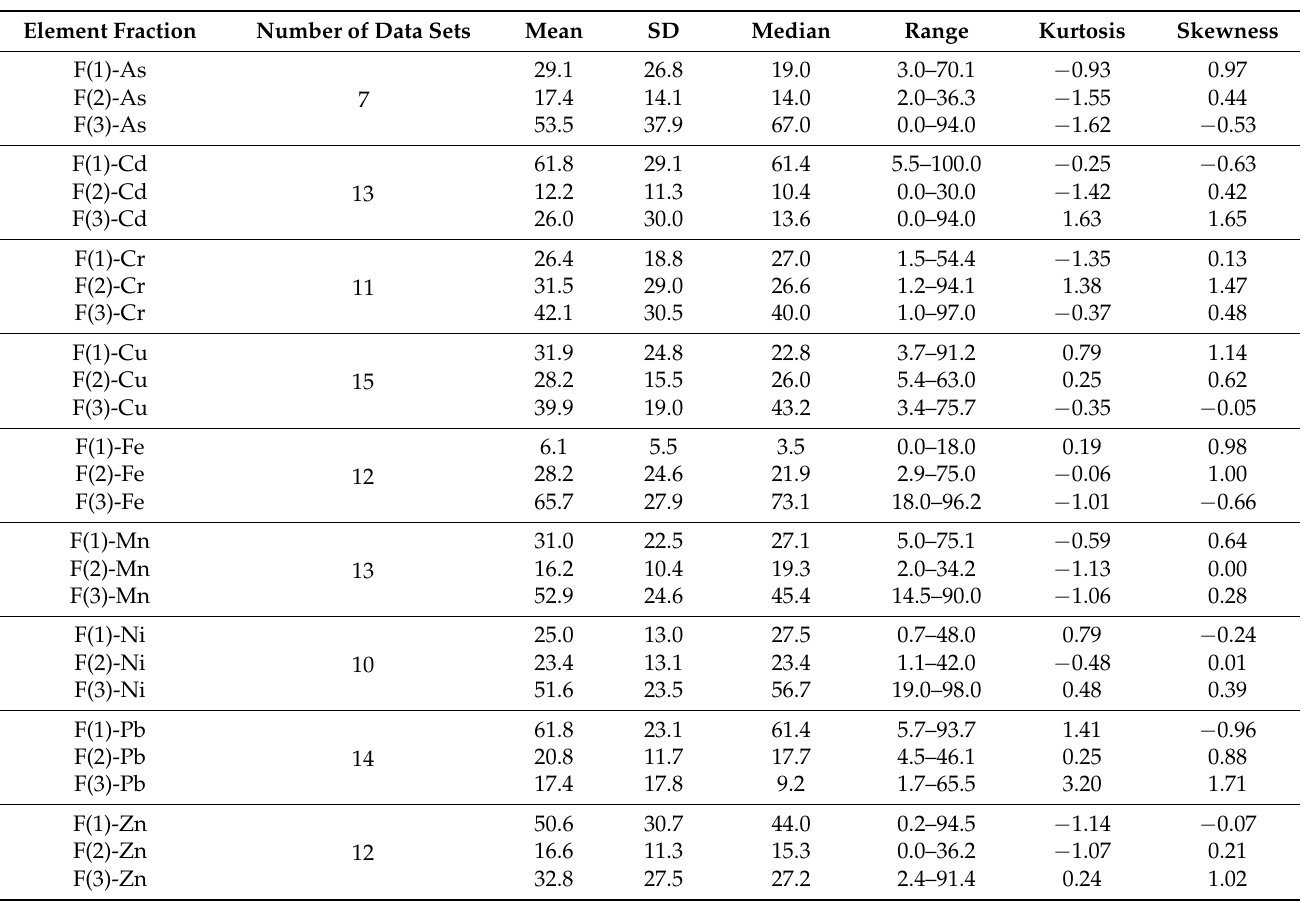
Table 4. Descriptive statistics of literature data of operational speciation of As, Cd, Co, Cr, Cu, Fe, Mn, Ni, Pb and Zn occurring in urban air particulate matter by Chester’s procedure. The element fraction content is given as a percentage of its total content